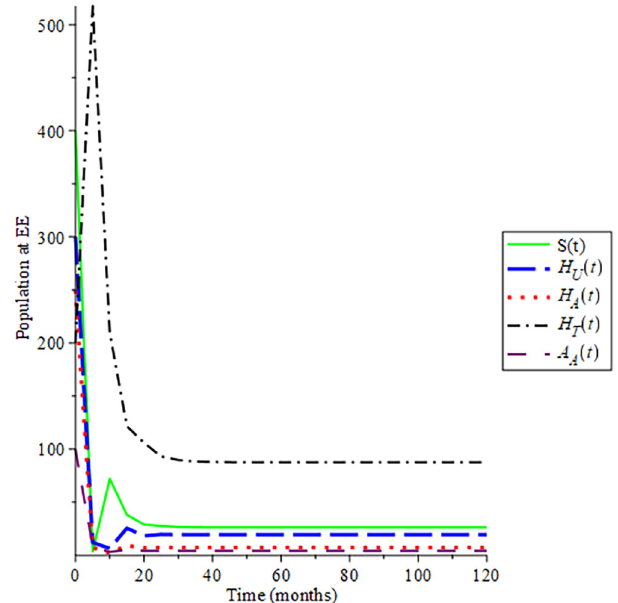
Figure 3. Proportion of different population HIV at EE when R 0 >